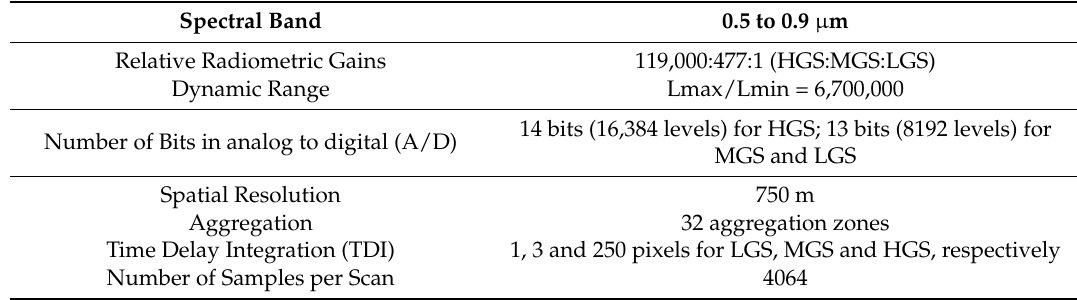
Design specifications for Suomi-National Polar-orbiting Partnership